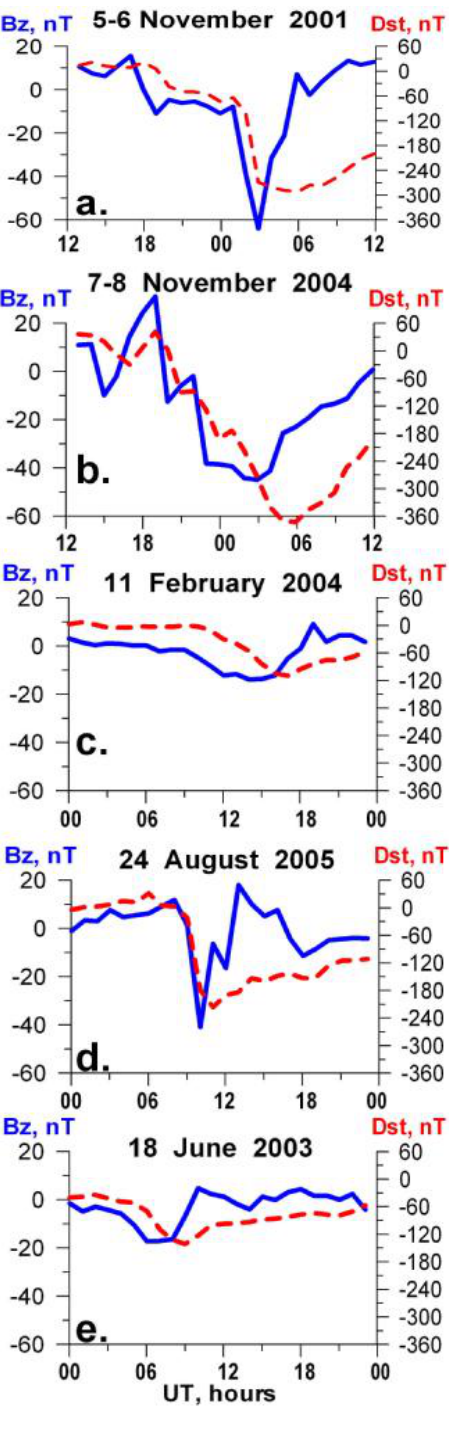
Fig. 1. Variations of the magnetic field component B z plotted for GSM coordinates (blue continuous curves) and of the index of geomagnetic activity D st (red dotted curves) during the analyzed